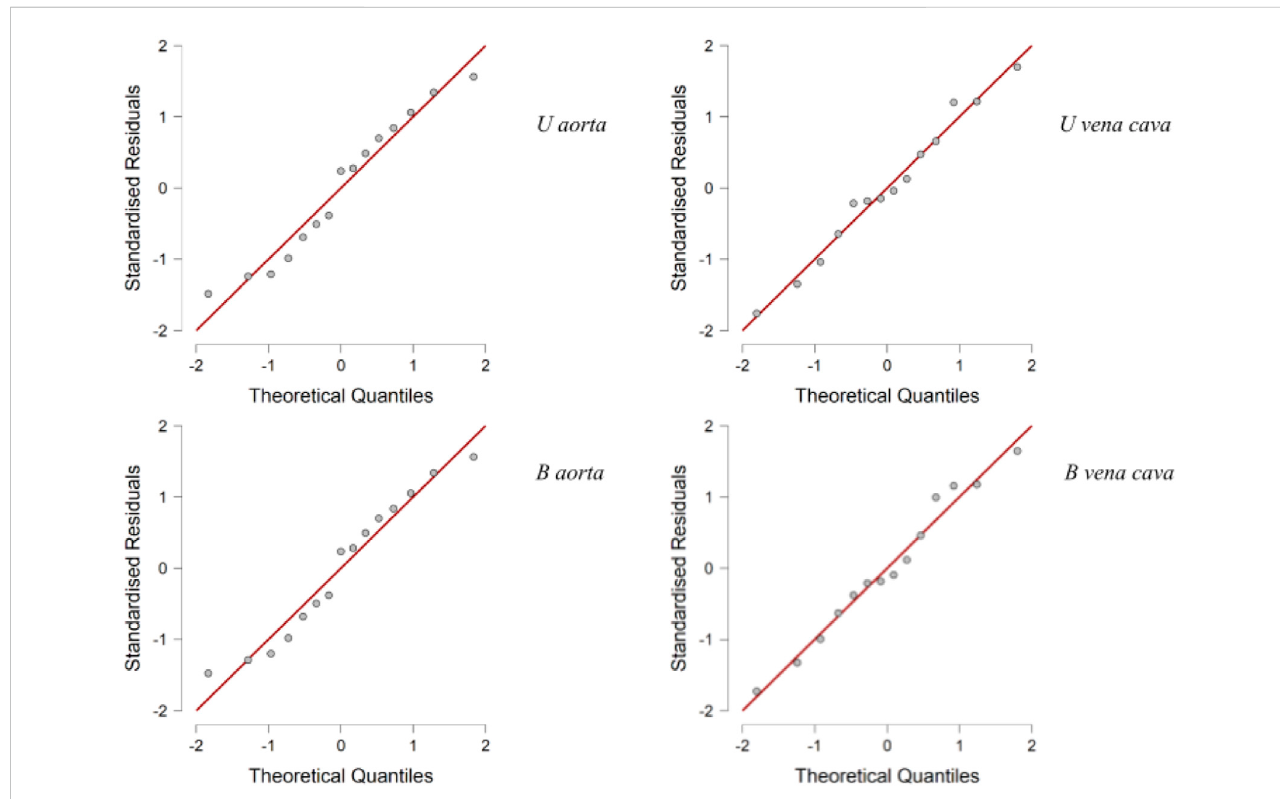
FIGURE 3 Q-Q Plots. Q-Q plot showing a distribution of data close to